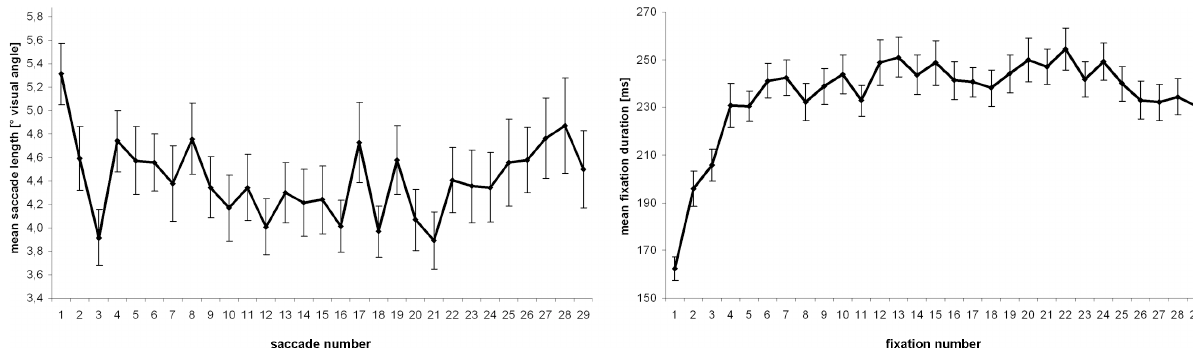
Figure 4. Mean saccade length (averaged across web pages) depicted against the actual saccade number (left side). Mean fixation duration depicted against the actual fixation number (right side). Vertical lines on top of bars indicate standard error of the mean.